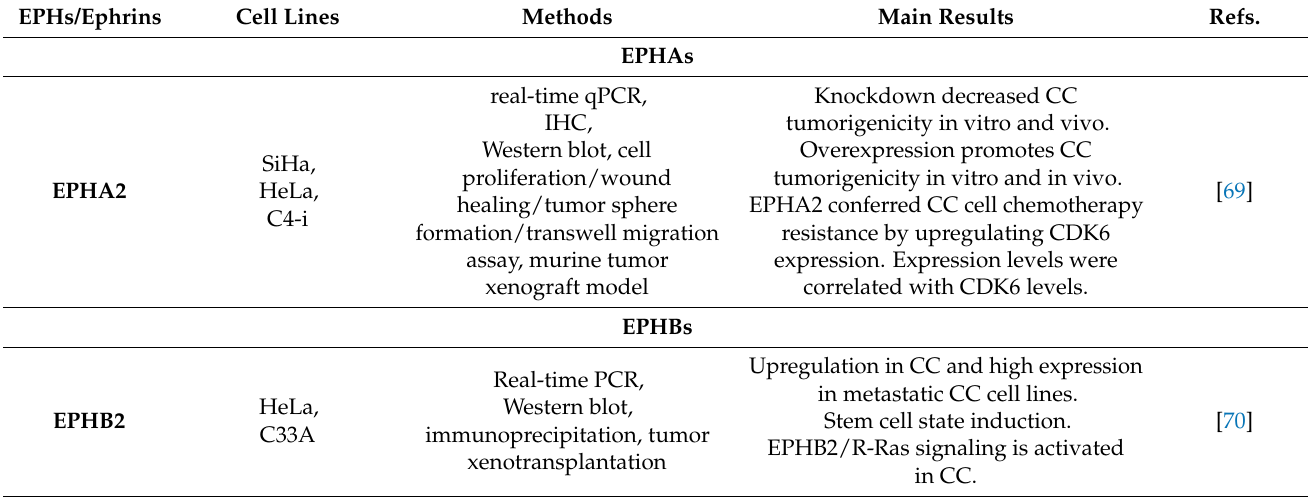
Table 6. The role of the EPH/ephrin system in CC cell lines and human